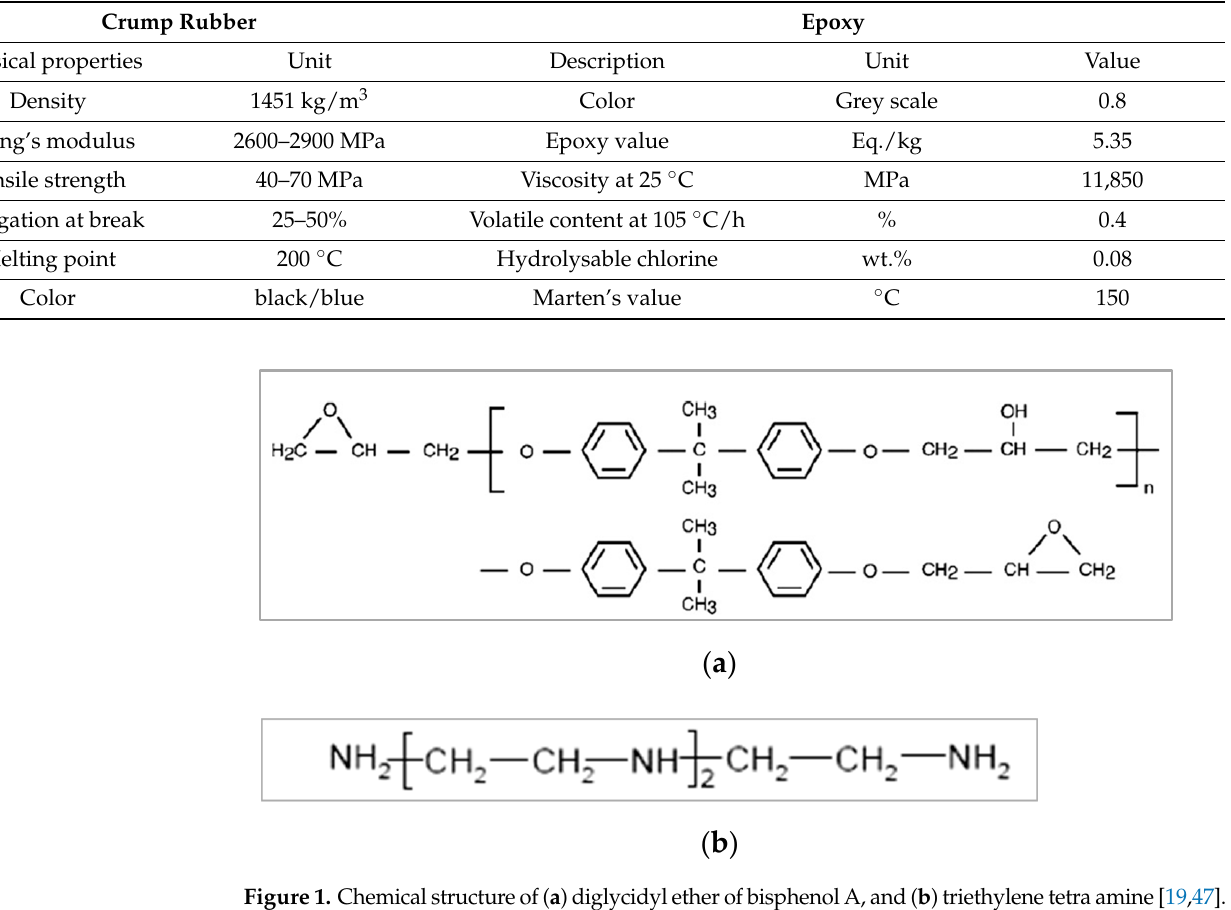
Figure 1. Chemical structure of ( a ) diglycidyl ether of bisphenol A, and ( b ) triethylene tetra amine [19,47].